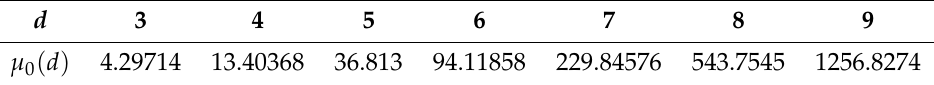
Table 1. Values for µ 0 ( d ) (Minimum of µ ( d ) to form a black hole) in different dimensions.